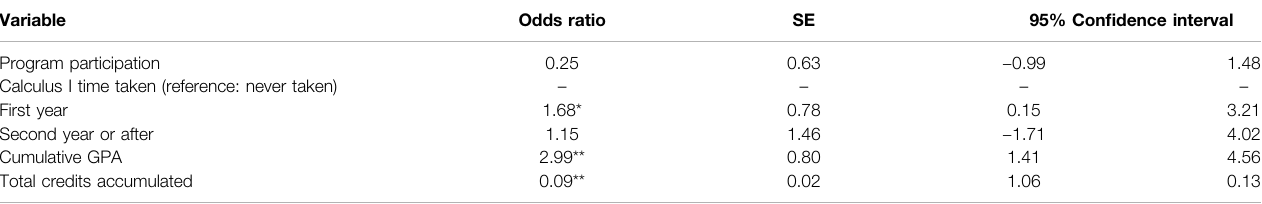
TABLE 5 | Logistic Regression Examining Graduation in Six-years. By Dina Ghazzawi, Donna Pattison, and Catherine Horn.